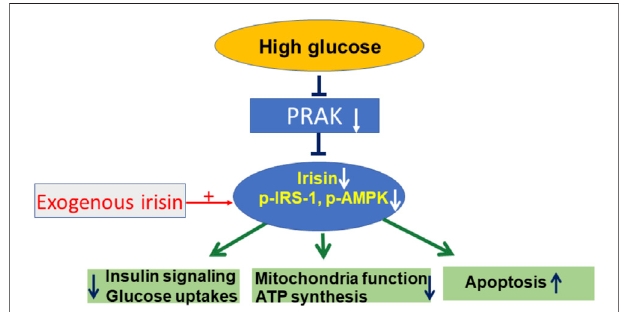
FIGURE 6 | The central mechanism of PRAK and irisin in regulation of insulin signaling and mitochondria function.